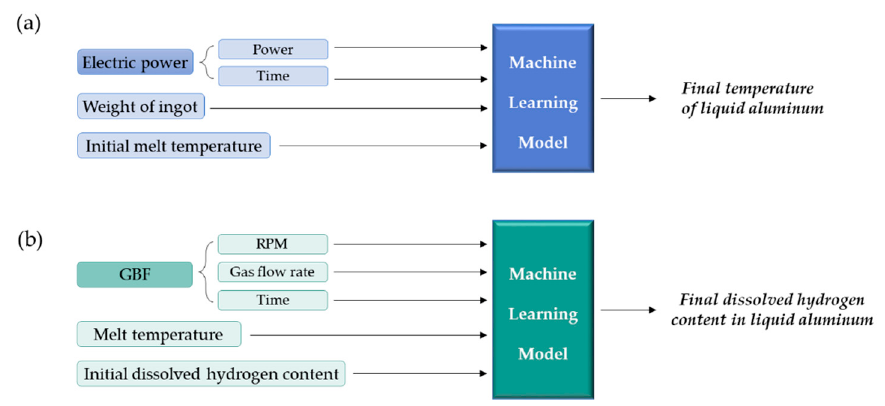
Figure 2. The architectures of the machine learning model to predict the ( a ) temperature in liquid aluminum and ( b ) dissolved hydrogen content in liquid aluminum.